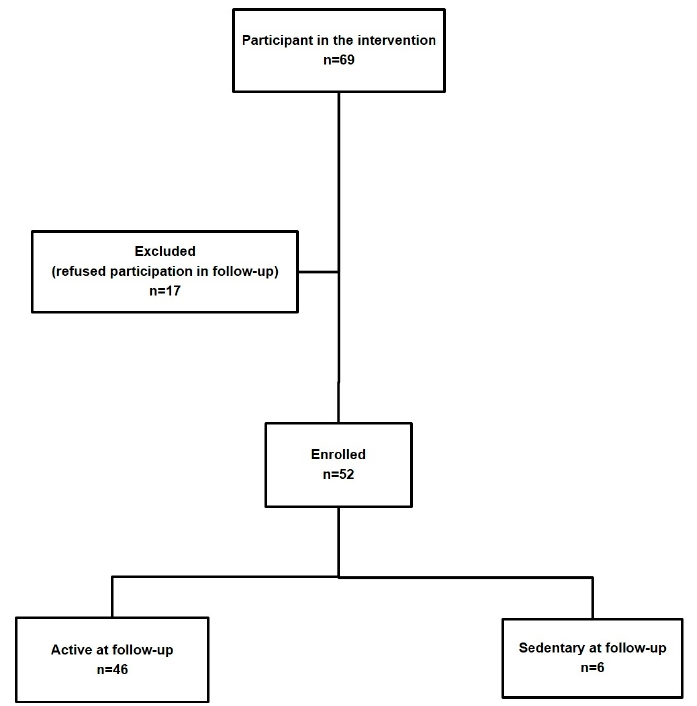
Figure 1. Flowchart for enrollment of participants in the follow-up study and their classification on the basis of habitual PA levels.